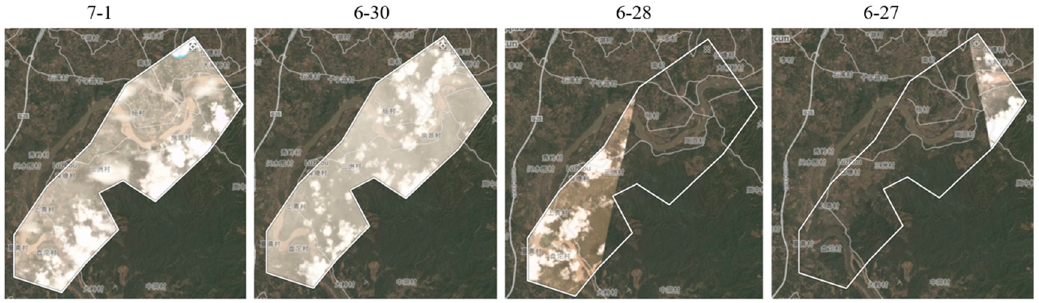
Figure 12. Image availability searched from Planet website (https://www.planet.com/).